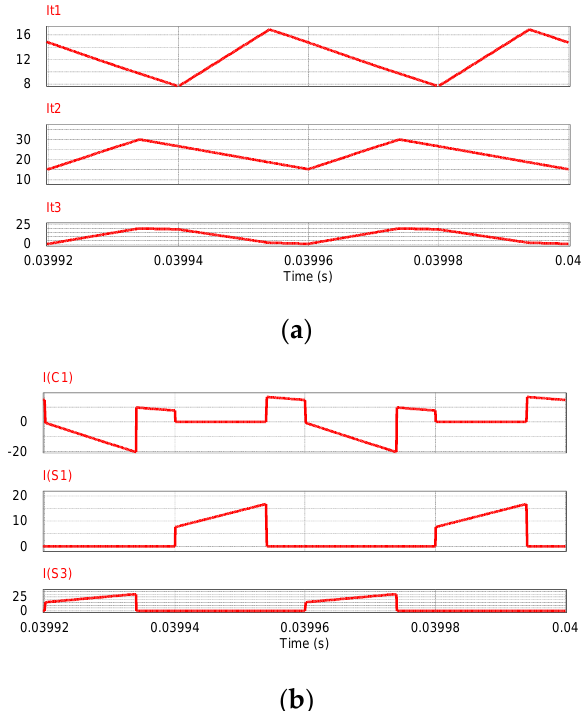
Figure 18. Current waveforms at output terminals and through some of the components of converter 3-3.1. ( a ) Current waveforms for it1, it2, and it3; ( b ) Coupling capacitor and switches S1 and S3 current waveforms. Table 4. Analytical and simulated data for converter 3-3.1 under